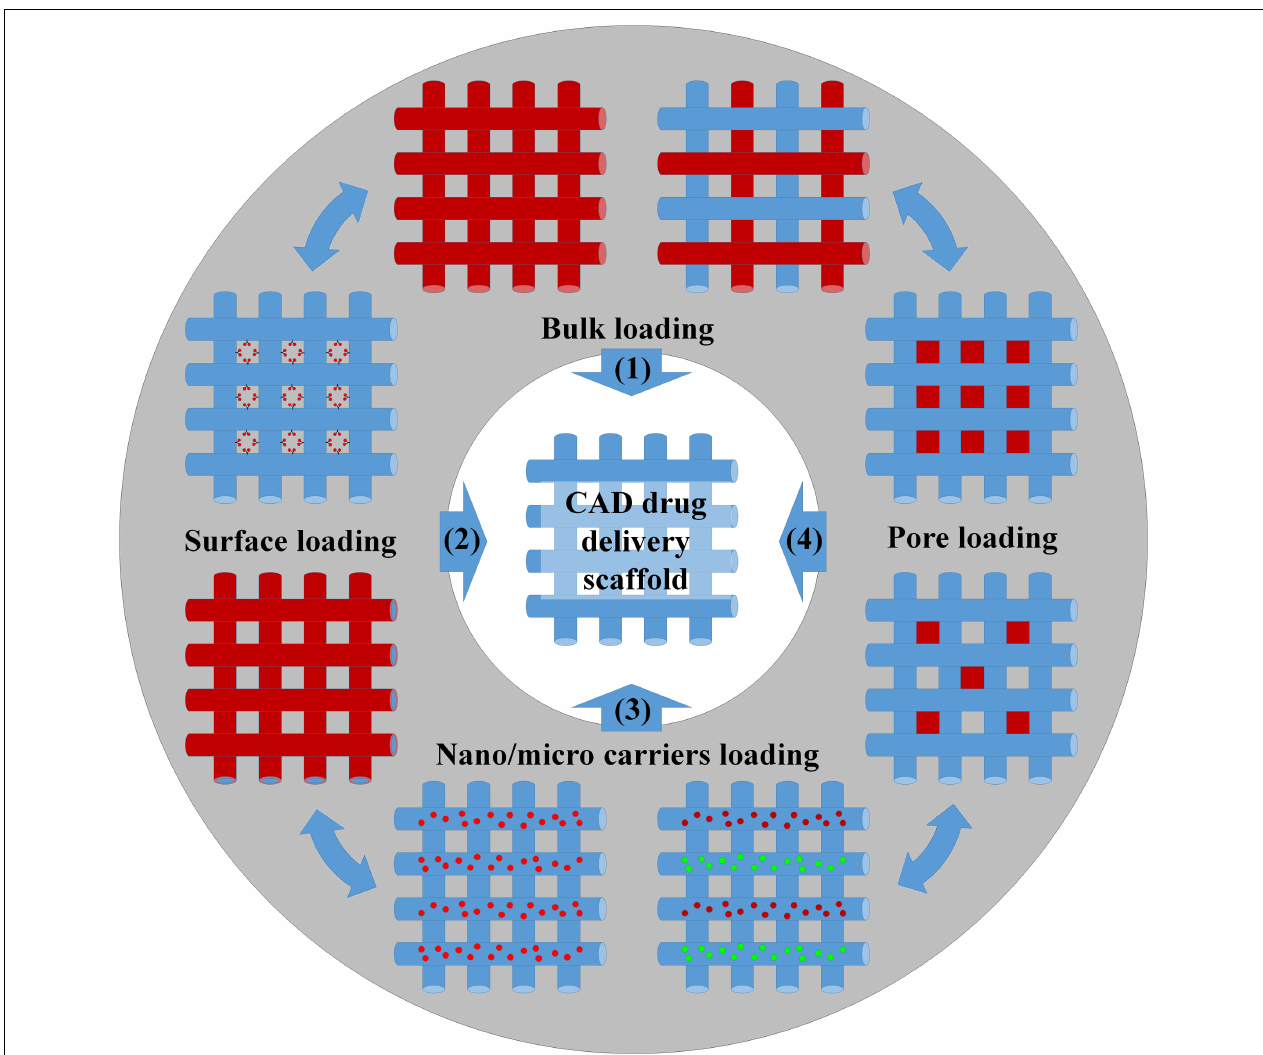
FIGURE 2 | Scheme of the different methods for the preparation of drug-loading scaffolds: (1) Bulk loading involved mixing drugs and biomaterials by melt/solution blending before 3D structure fabrication or, alternatively, by wet/supercritical CO 2 impregnation of the settled scaffold. (2) Surface bioactivation required the adsorption/grafting of the biomolecules to the scaffold surface or the incorporation of the biomolecules inside the coatings. (3) Biomolecules were loaded inside nano/microcarriers, and the carriers were further blended with the scaffold matrix before manufacturing. (4) The biomolecules were loaded into the scaffold pores using a carrier system (e.g.,